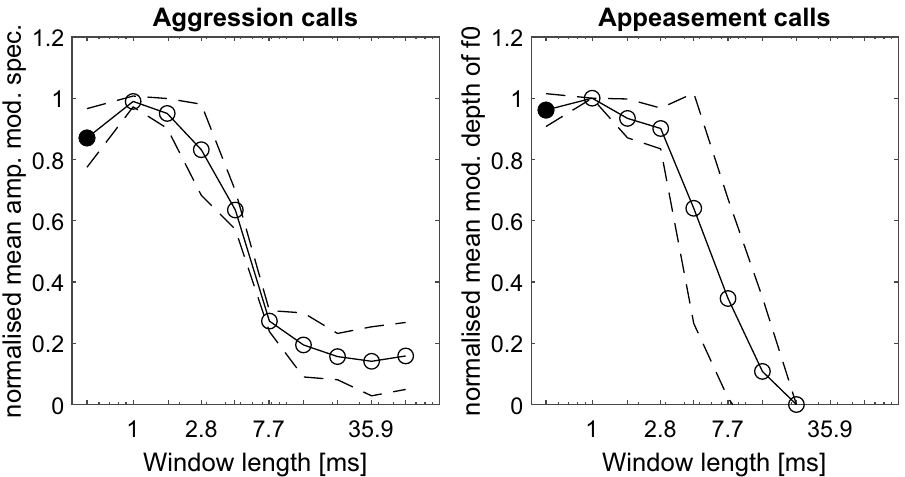
Figure 2. Phase-randomization changes temporal and spectral modulation cues. Left: The spectrum of amplitude-modulation rates in the aggression calls changes as a function of phase-randomization window- length. Peak magnitudes for original calls (filled circle) and respective distorted versions (circles) were normalised and averaged across the five aggression calls. Right: The depth of SFM of the fundamental frequency f 0 in the appeasement calls changes as a function of phase-randomization window-length. Peak SFM depth for f 0 of original calls (filled circle) and respective distorted versions (circles) were normalised and averaged across the five appeasement calls. Dashed lines depict the standard deviation. Note that AM rate spectrum and SFM depth are exemplary technical measures to visualize the distortion of modulation patterns and should therefore neither be directly compared with each other nor to the psychometric